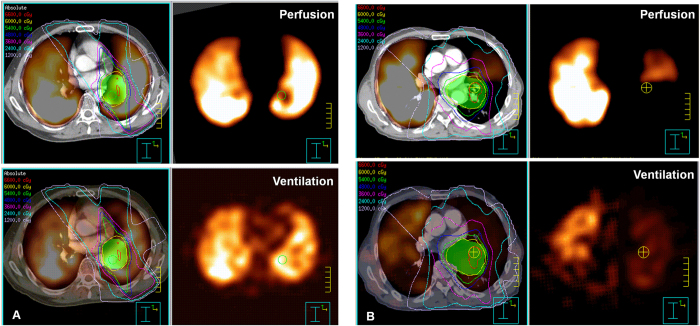
(A) The RT plannings and V/Q functional regions distribution of a patient with G3 (Grade 3) RILT. (B) The RT plannings and V/Q functional regions distribution of a patient with G1 (Grade 1) RILT. RILT, radiation-induced lung toxicity.